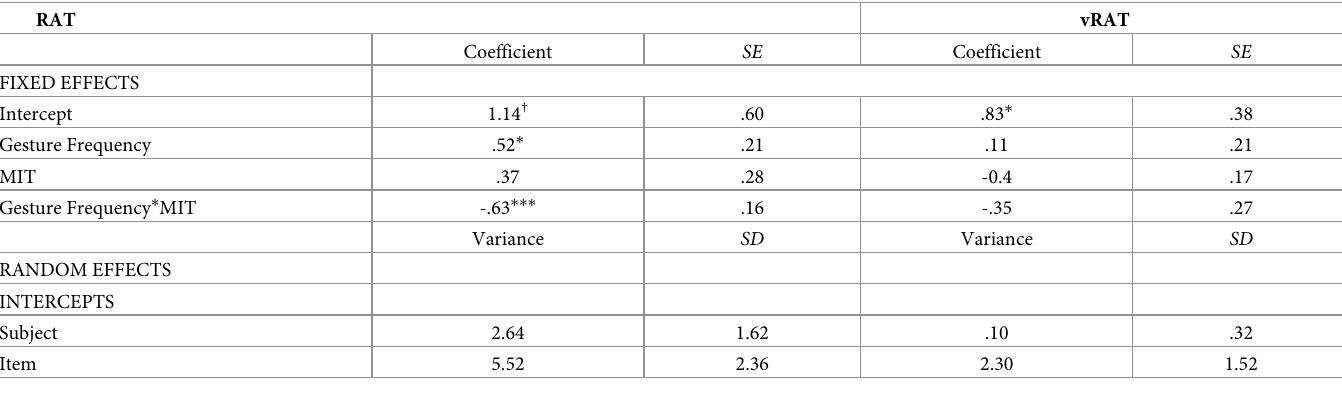
Table 2. Model summary for Hypothesis